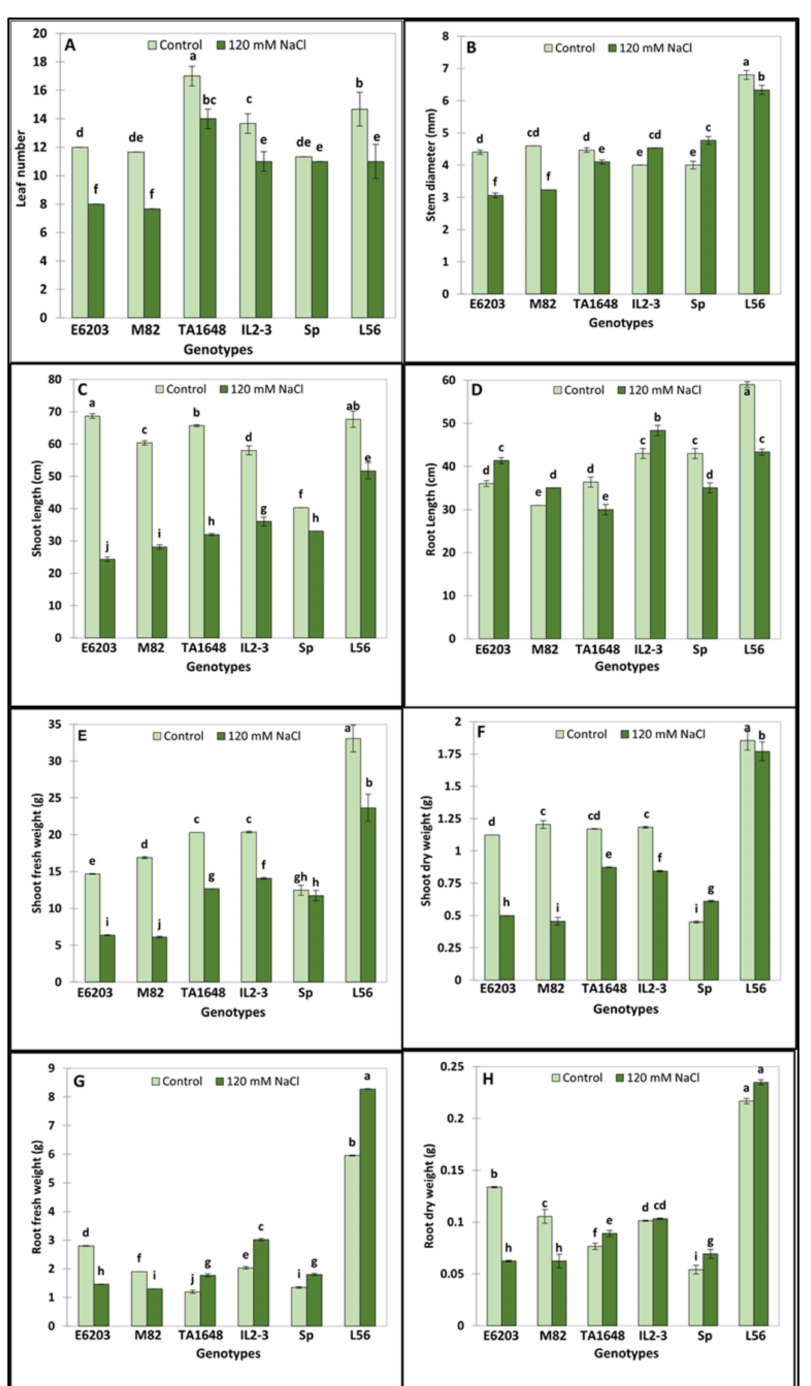
Figure 3. Salt tolerance evaluation under a hydroponic system of two ILs TA1648 and IL2-3 in comparison to two salt-sensitive cultivated tomato varieties “E6203, and M82” and two salt-tolerant reference genotypes, “LA0716” (wild type: SP) and “L56” (fixed variety). Two treatments control and 120 mM NaCl, were used. ( A ) Leaf number (LN), ( B ) stem diameter (SD), ( C ) shoot length (SL), ( D ) root length (RL), ( E ) shoot fresh weight (SFW), ( F ) shoot dry weight (SDW), ( G ) root fresh weight (RFW), and ( H ) root dry weight (RDW). Data are the means of three replicates ± standard deviation; different letters on bars represent the significant values according to Duncan’s test ( p <